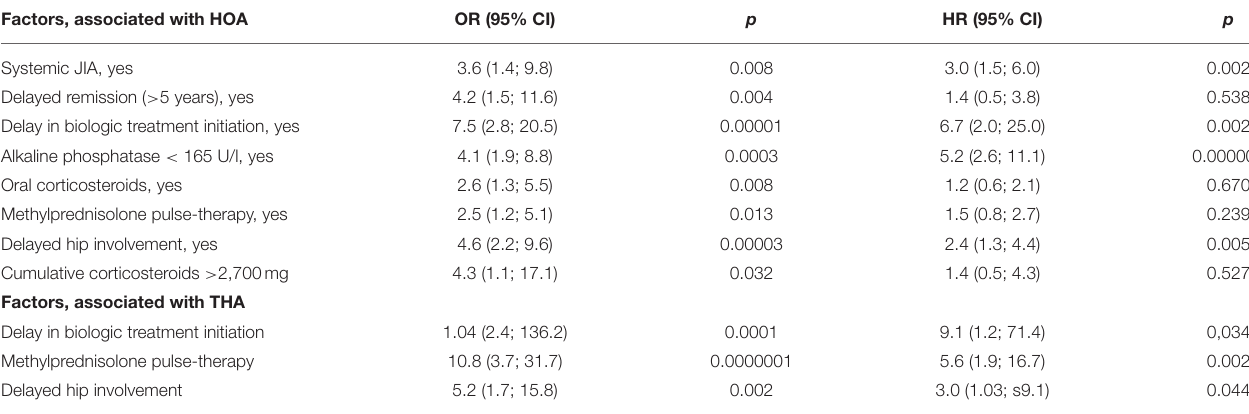
TABLE 3 | Factors, associated with hip osteoarthritis and total hip arthroplasty. Factors, associated with HOA OR (95% CI) p p Systemic JIA,